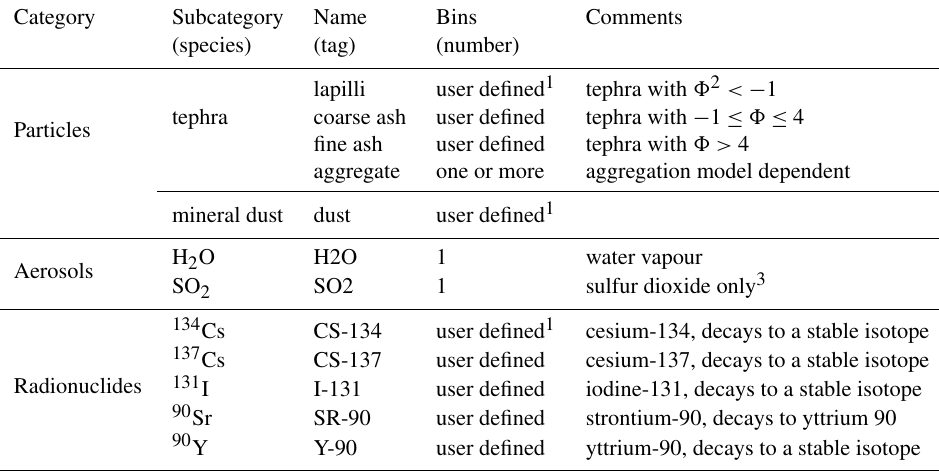
Table 3. Types of categories and related subcategories of species in